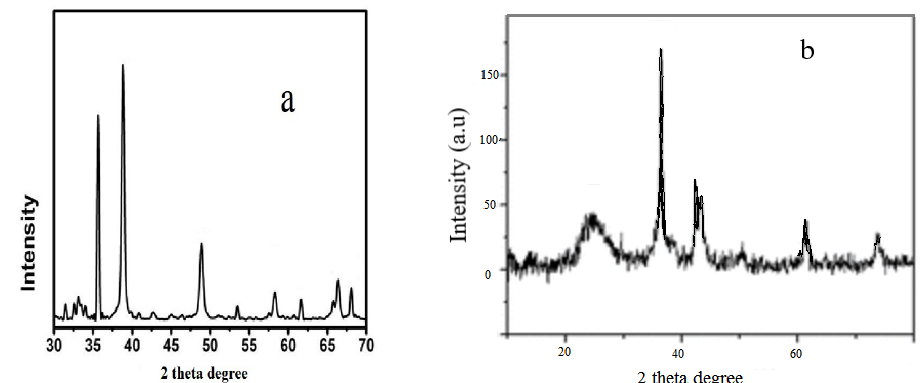
Fig. 2. (a). Powder XRD pattern of CuO nanoparticles and (b). CuO NPs – rGO